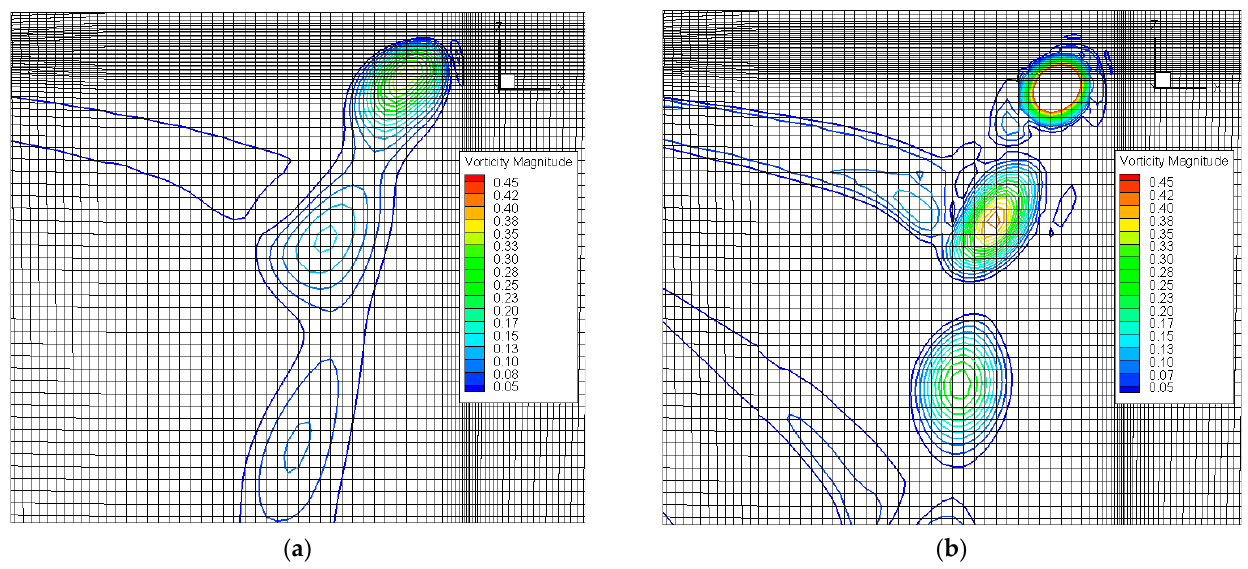
Figure 7. Comparison of local grid section and the vorticity contour of tip vortices. ( a ) MUSCL–Roe ( b ) WENO–Roe.